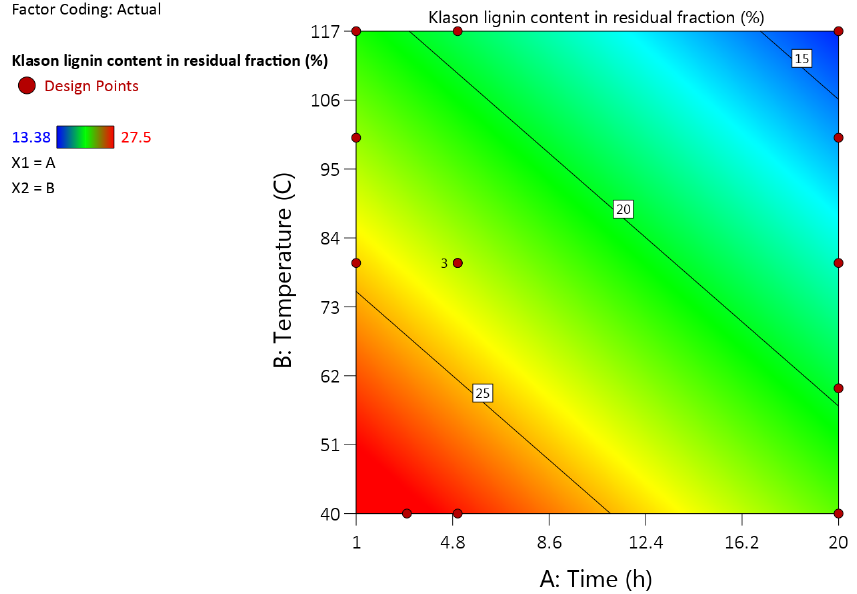
Figure 4. Klason lignin content in residual fraction in dependence of temperature and process time. Table 2. Precipitated lignin-enriched fraction and insoluble cellulose-enriched fractions yields on dry matter of extracted bark depending on used solvent